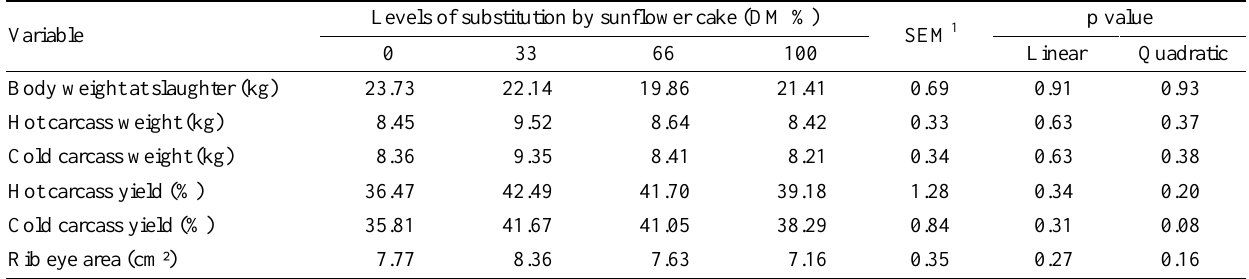
Table 3. Body weight at slaughter, hot and cold carcass weight, hot and cold carcass yield and rib eye area of 1/2 Boer kids fed diets containing sunflower cake Variable